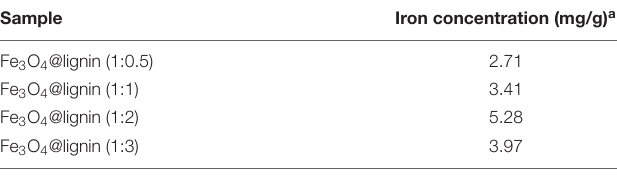
TABLE 1 | Iron content of magnetic lignin